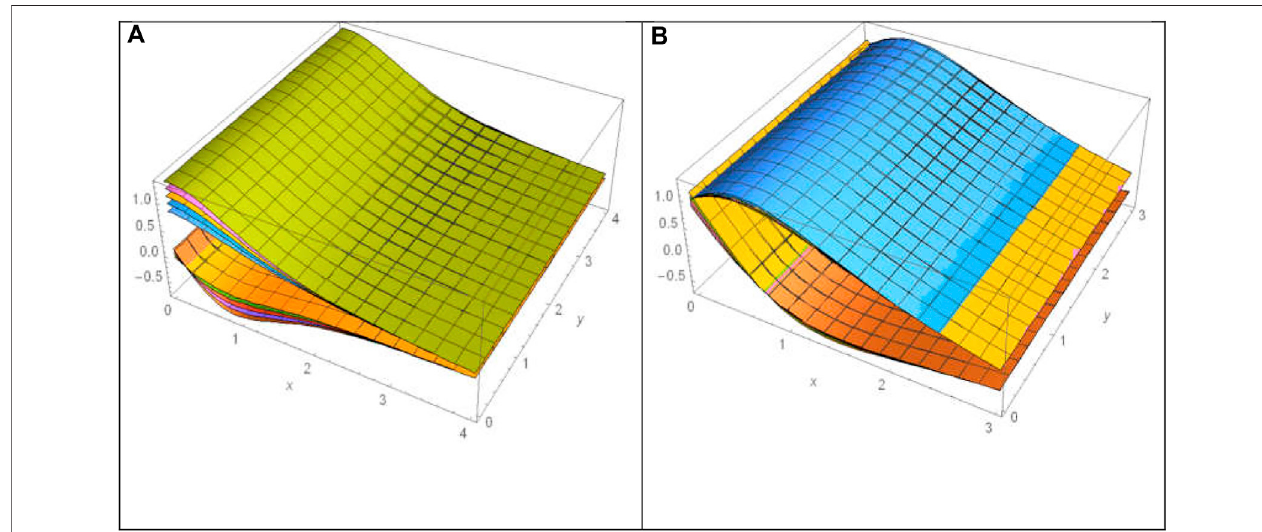
FIGURE 5 | 3D view of β ( ζ ) and β ′ ( ζ ) for (A) Ec and (B) m .